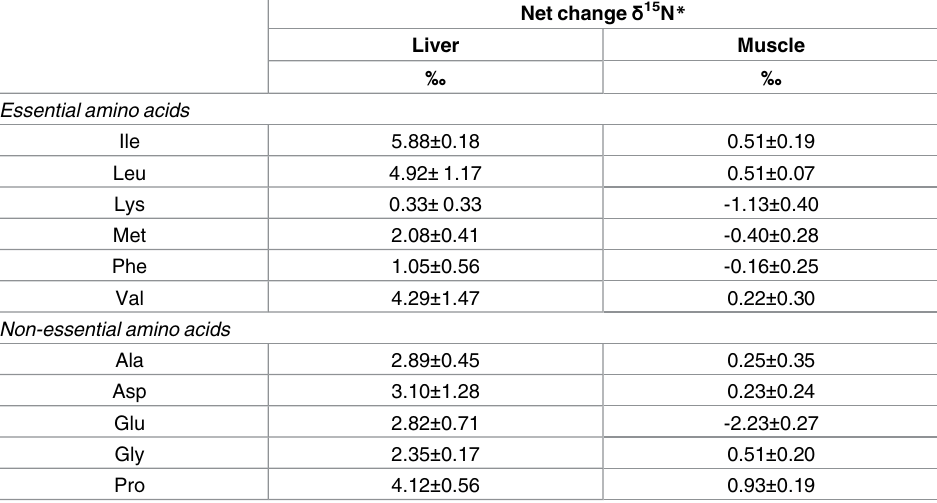
Table 5. Starvation-induced net changes in 15 N enrichment of individual amino acids in liver and mus- cle tissue of S . lalandi after 35 days of starvation.